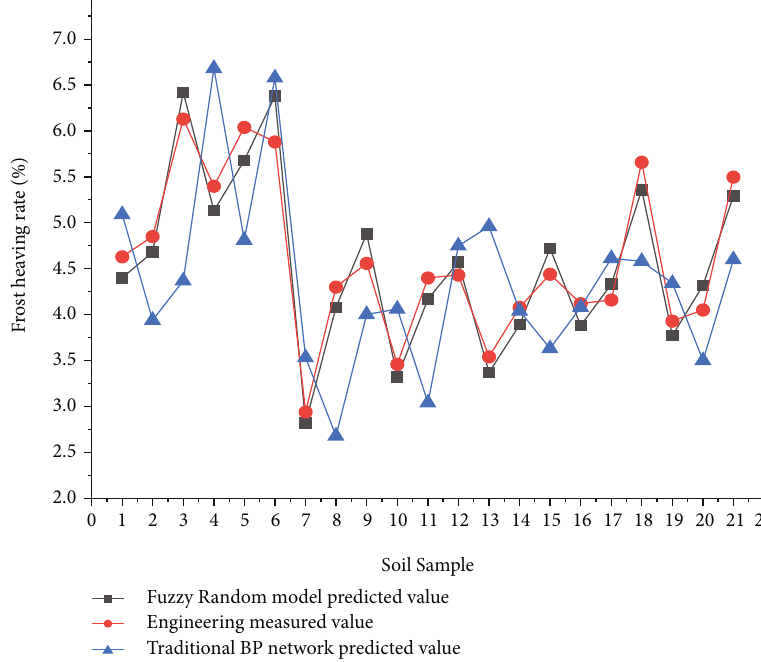
Figure 9: Comparison of fuzzy random model predicted and measured values of frost heaving